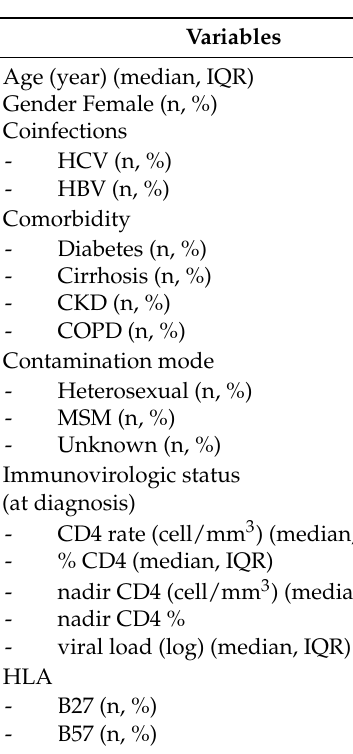
Table 1. Baseline